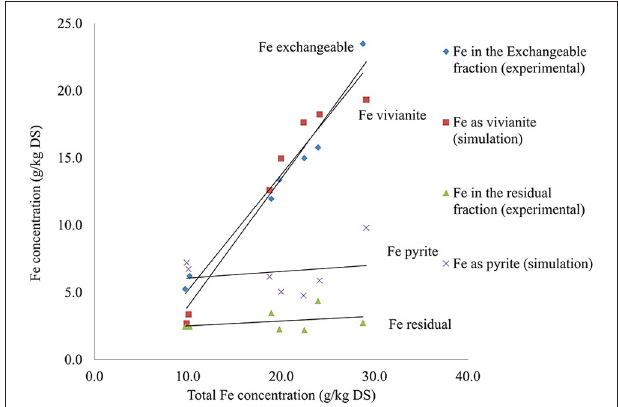
FIGURE 4 | Comparison of iron concentrations between experimental and predicted